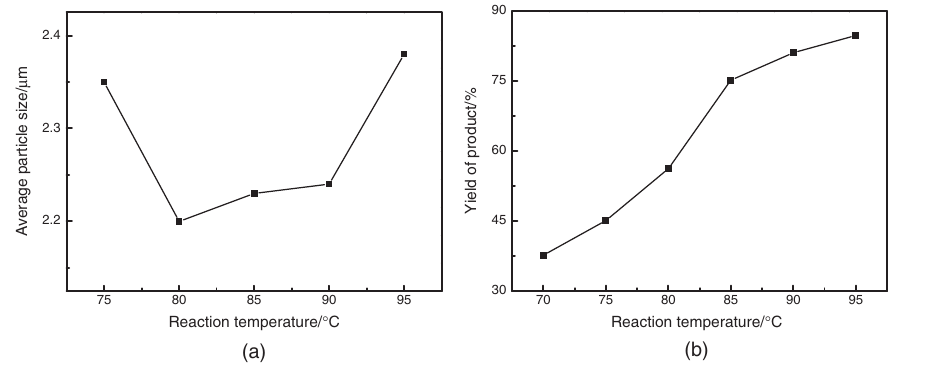
Figure 5: Effect of reaction temperature on average particle size (a) and yield of product (b) in the microwave homogeneous precipitation, respectively.